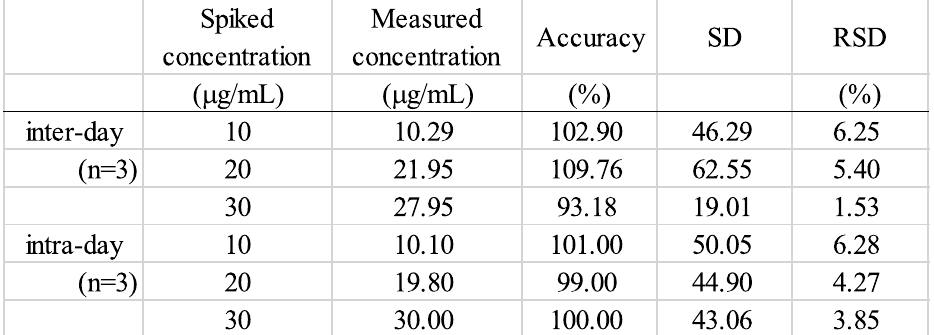
Table 1. Inter-day and intra-day accuracy and validation at three different